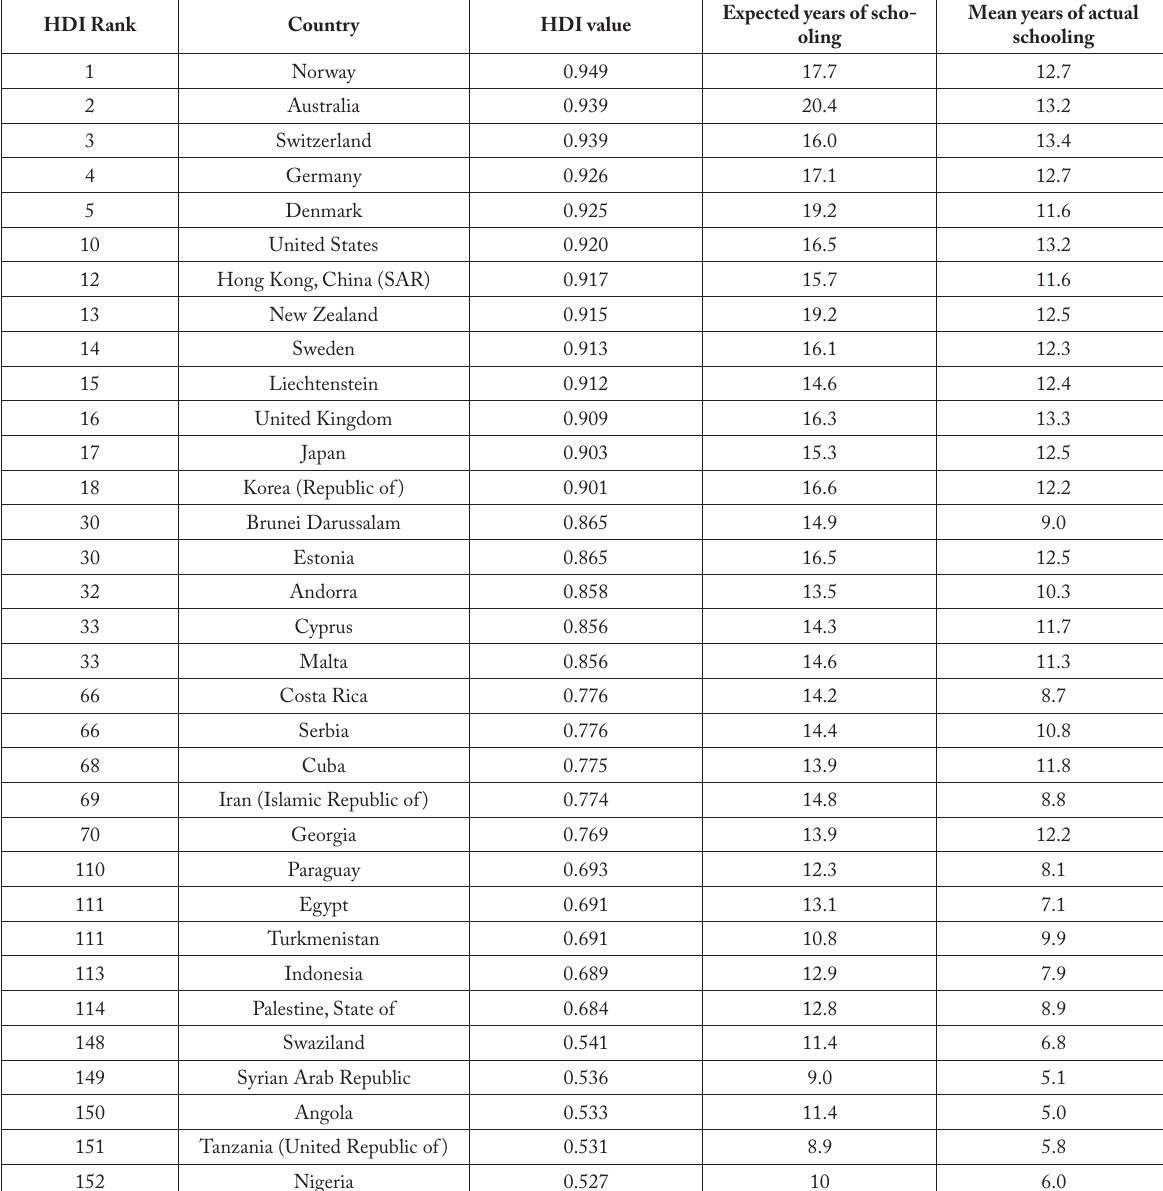
Table 9. Differences in educational levels between developing and developed countries based on the HDI values and ranks